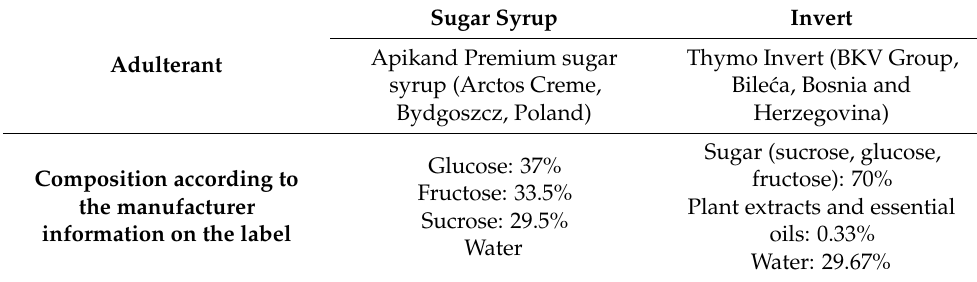
Table 4. Characteristics of used